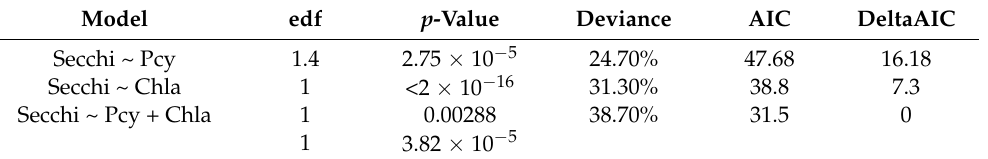
Table 2. Statistics from fitted GAMs to the “validation” dataset; grey shadow represents the best fitted model based on AIC and the percentage of deviance explained; edf, estimated degrees of freedom; p -value < 0.05 is statistically significant; AIC, Akaike Information Criterion; deltaAIC is the difference with respect to the lowest AIC